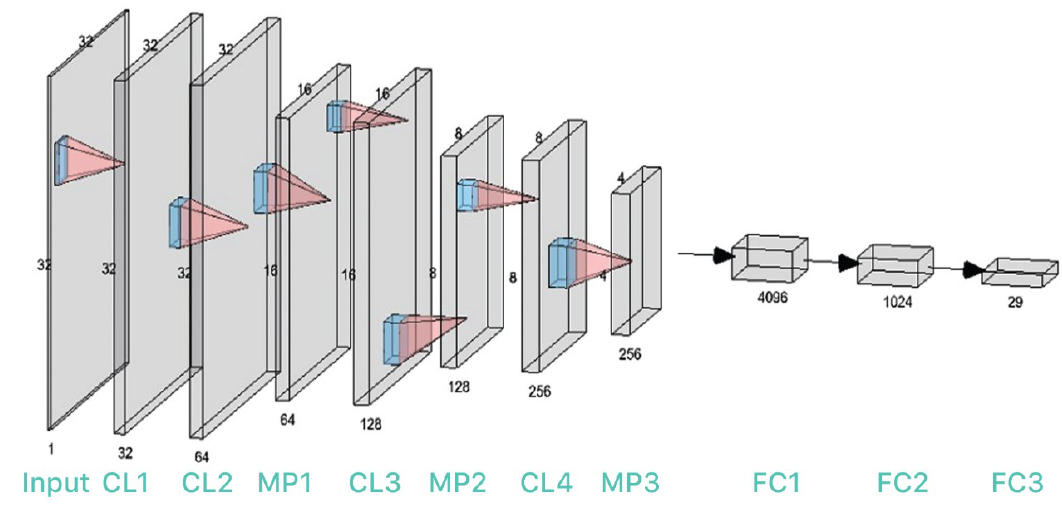
Figure 2. Our CNN